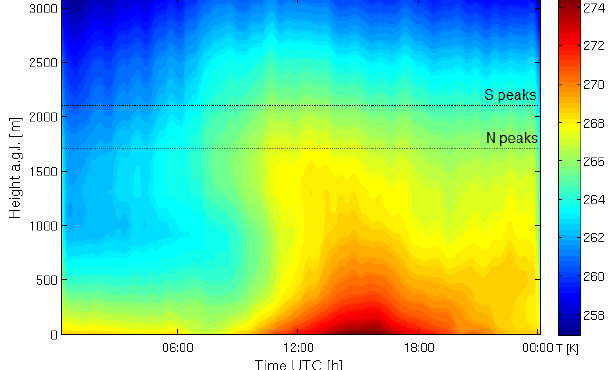
Figure 11. Daily temperature evolution for 14 February 2013 ob- tained from IMGI retrieval (with no additional regressors) in the lower part of atmosphere. The time is expressed in UTC and the height is expressed in meters above ground level (a.g.l.). The dot- ted horizontal lines correspond to the approximate peak heights to- wards the north (N, about 1700m) and south of the valley (S, about